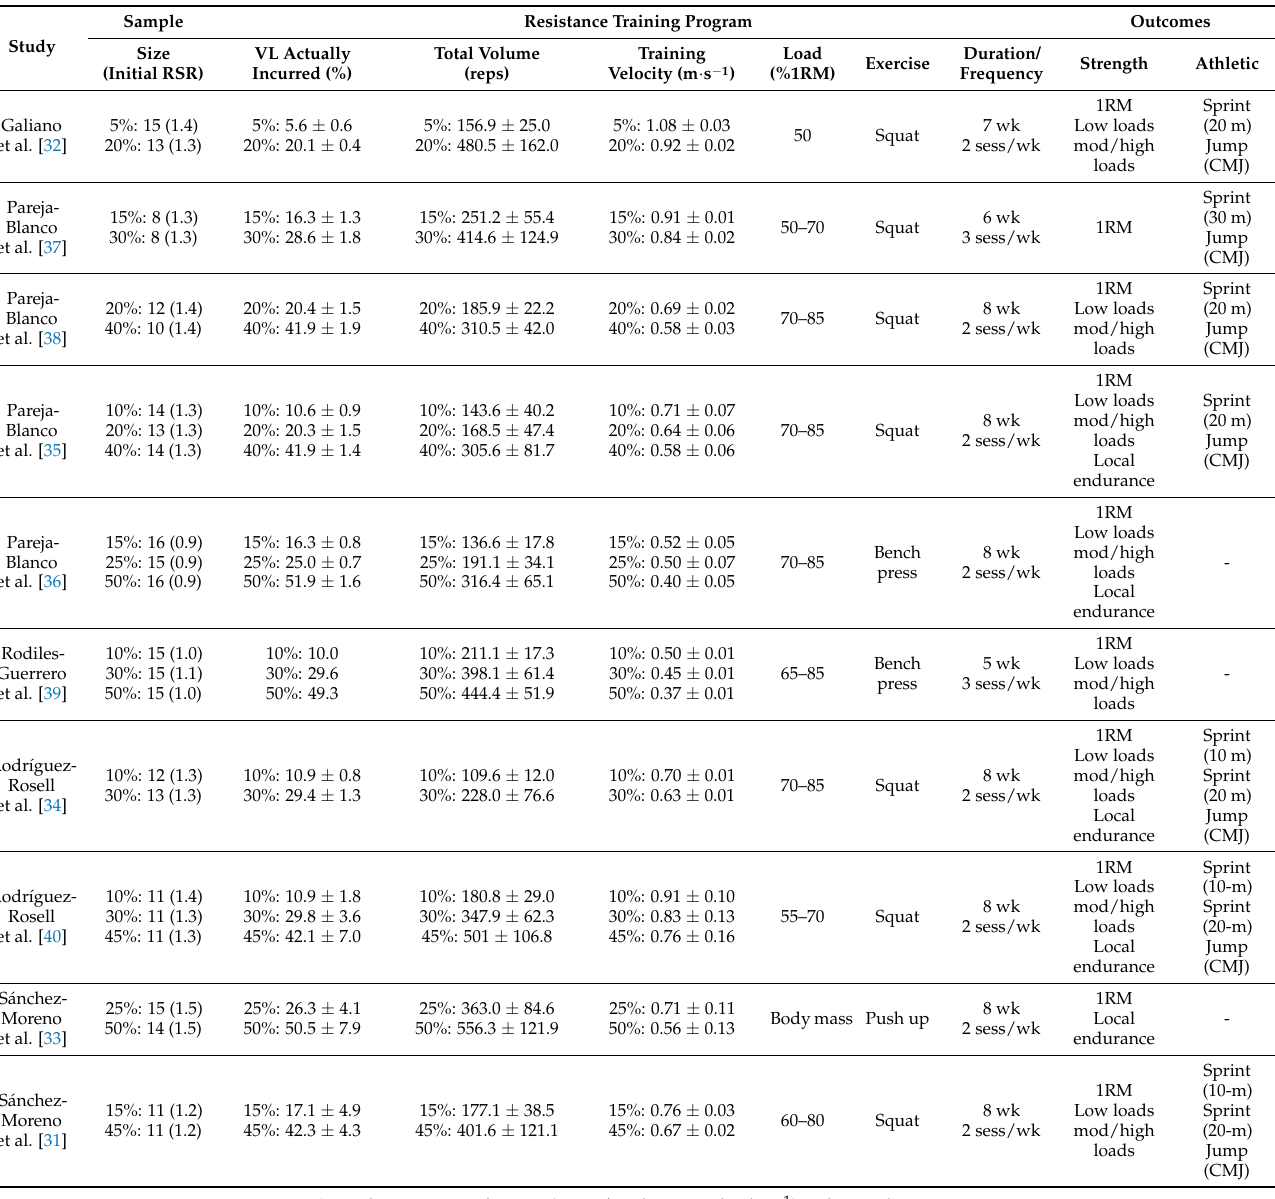
Table 2. Characteristics of the included